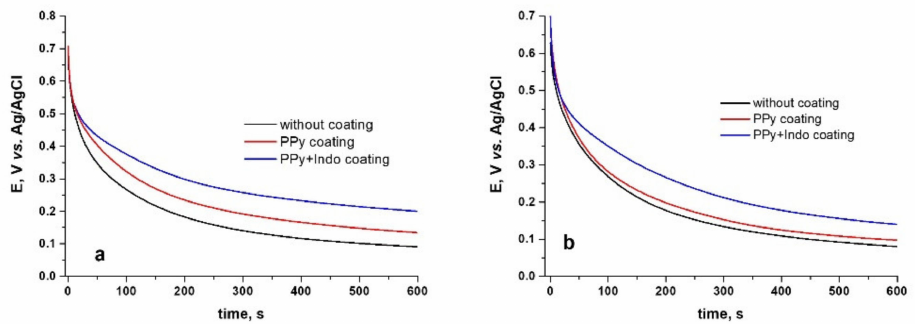
Figure 6. Open circuit potential behavior in Tani-Zuchi artificial saliva at 37 ◦ C for the coated and uncoated WBC ( a ) and Hera ( b ) CoCr-based